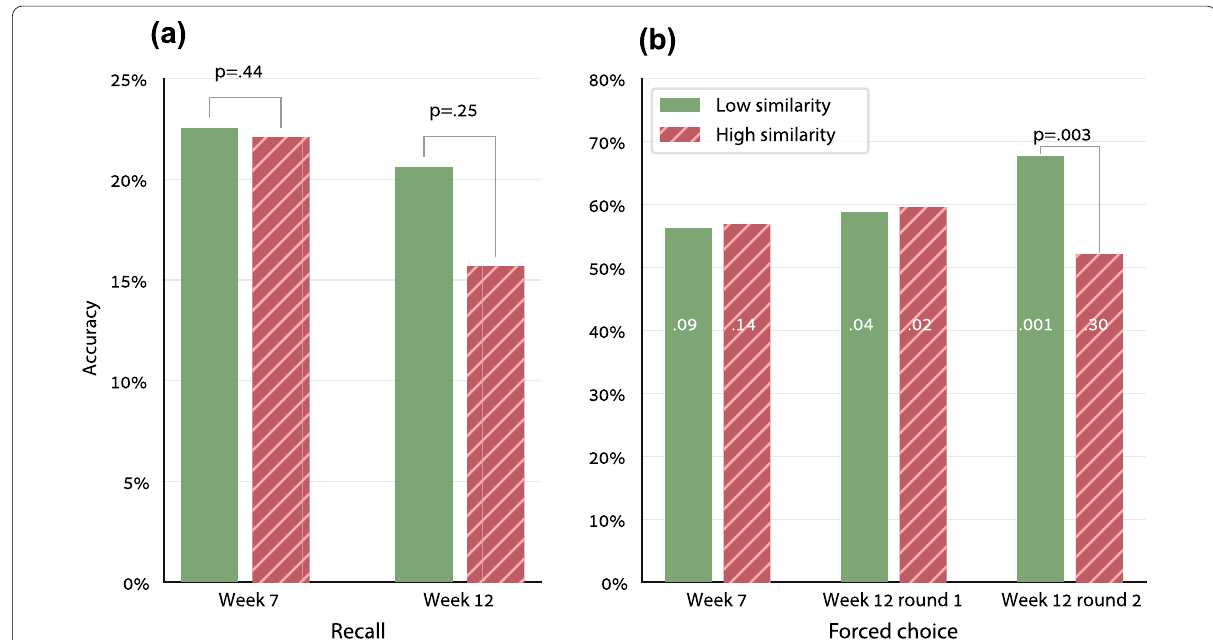
Fig. 5 The effect of similarity on accuracy in the post‑experiment tests—the recall tests (average of sessions #1–3 in each week) and the two‑alternative forced‑choice tests (session #4 in each week). Only the trained facts are shown here. The p values above the columns are the effect of the Numeric Similarity factor in the LLMM described in the text. The p values inside the forced‑choice columns refer to comparing the per‑participant mean accuracies to chance level (paired t‑test against 50%, one‑tailed p